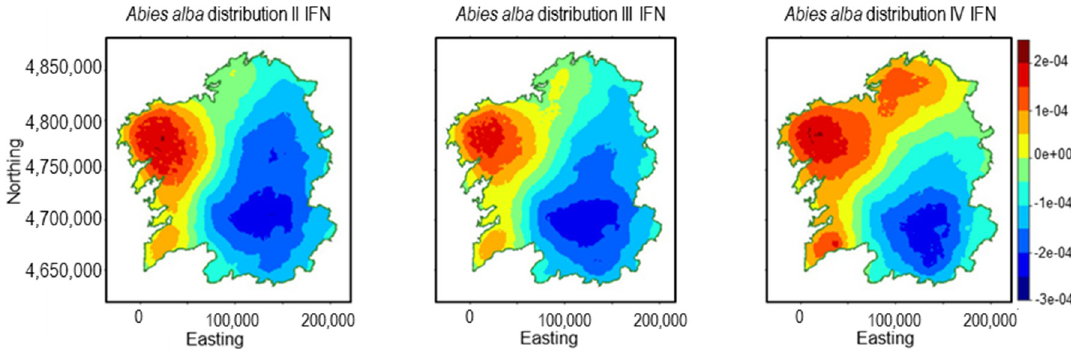
Figure 3. Maps of the posterior mean of the spatial field from the spatial model of A. alba , II, III, and IV forest inventories (coordinates in m.).